Question: Looking at the figure, what chart type is it?
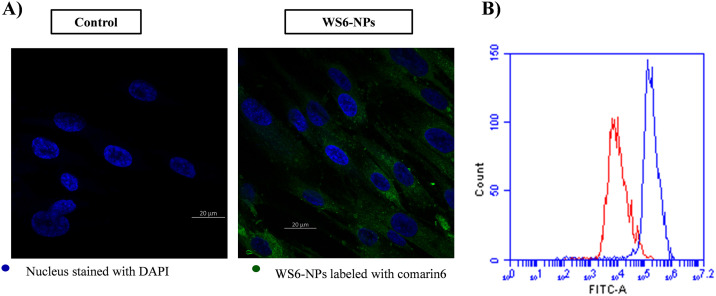
Answer: histogram